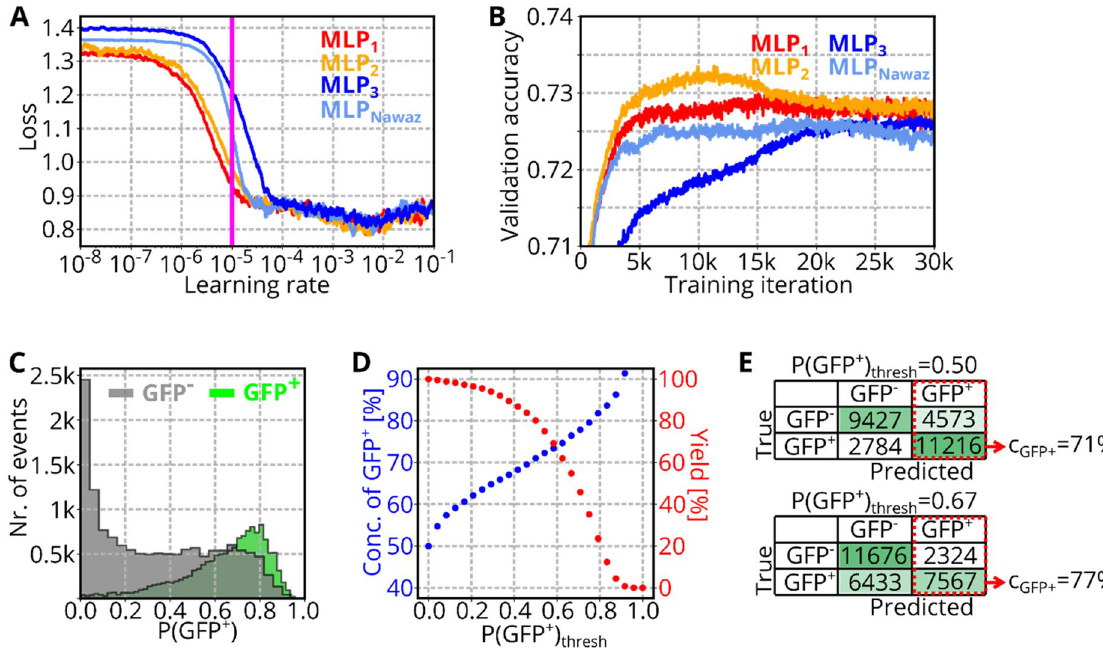
Figure 6. MLP training and assessment. ( A ) Plot shows a learning rate screening for all MLP architectures. During screening, MLPs are trained using the available training data and data augmentation methods are applied. The learning rate screening was performed using AIDeveloper 0.2.3. ( B ) Plot shows the validation accuracy during training of four MLPs to distinguish GFP - and GFP + cells. For a smooth appearance, each line shows the rolling median (window size = 50). ( C ) Green and gray histogram show the probabilities returned by MLP 2 for each event the GFP + and GFP - class of the validation set. ( D ) Scatterplot shows the concentration and yield of GFP + rod photoreceptors when applying MLP 2 to the validation set using different threshold values P(GFP + ) thresh for prediction. ( E ) Confusion matrices when using a threshold P(GFP + ) thresh of 0.5 and 0.67. The red rectangle indicates the events that are predicted to be GFP + . Those events would be sorted during a sorting experiment, resulting in a particular concentration of GFP + cells (c GFP+ ) in the sorted sample.